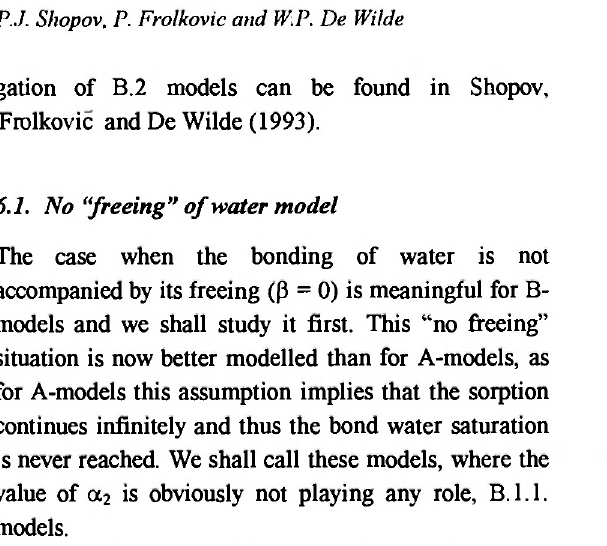
Fig. 11a: Free and bond water for B.l.l., a = 2, γ' = 100, 1,0.1.